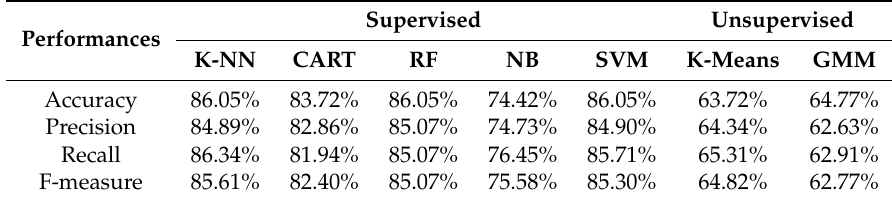
Table 5. Accuracy, Precision, Recall and F-measure for each classifier in the case of the Yogev et al. sub-dataset.